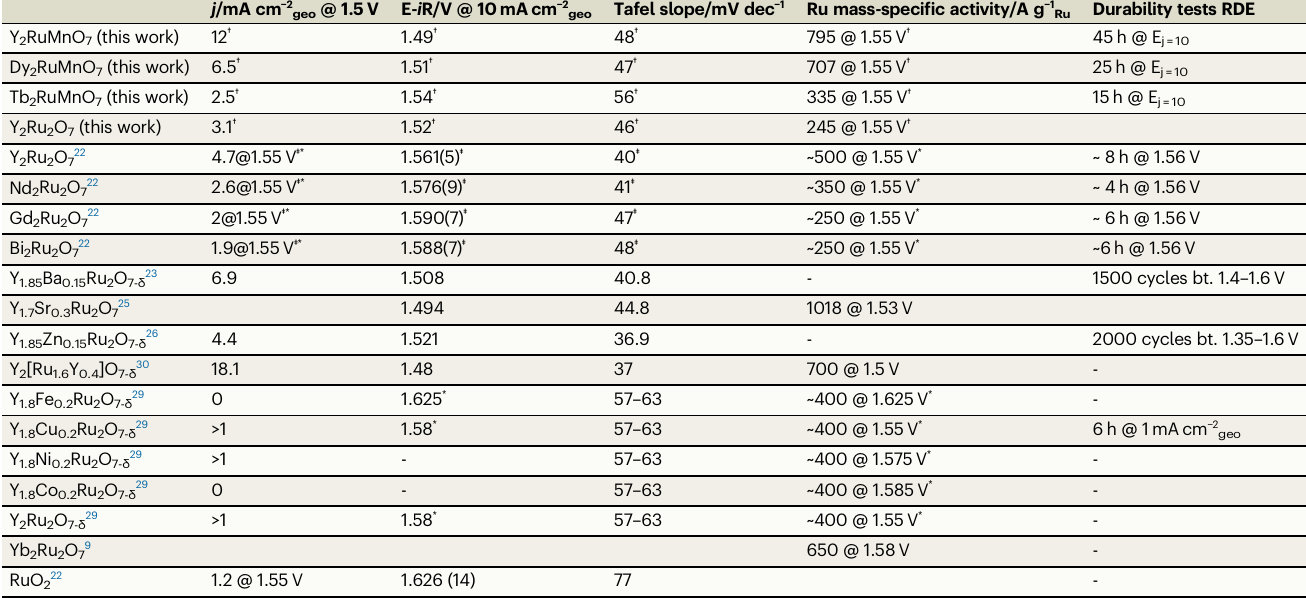
Table 1 | Performance of Ru pyrochlores for the OER in acidic